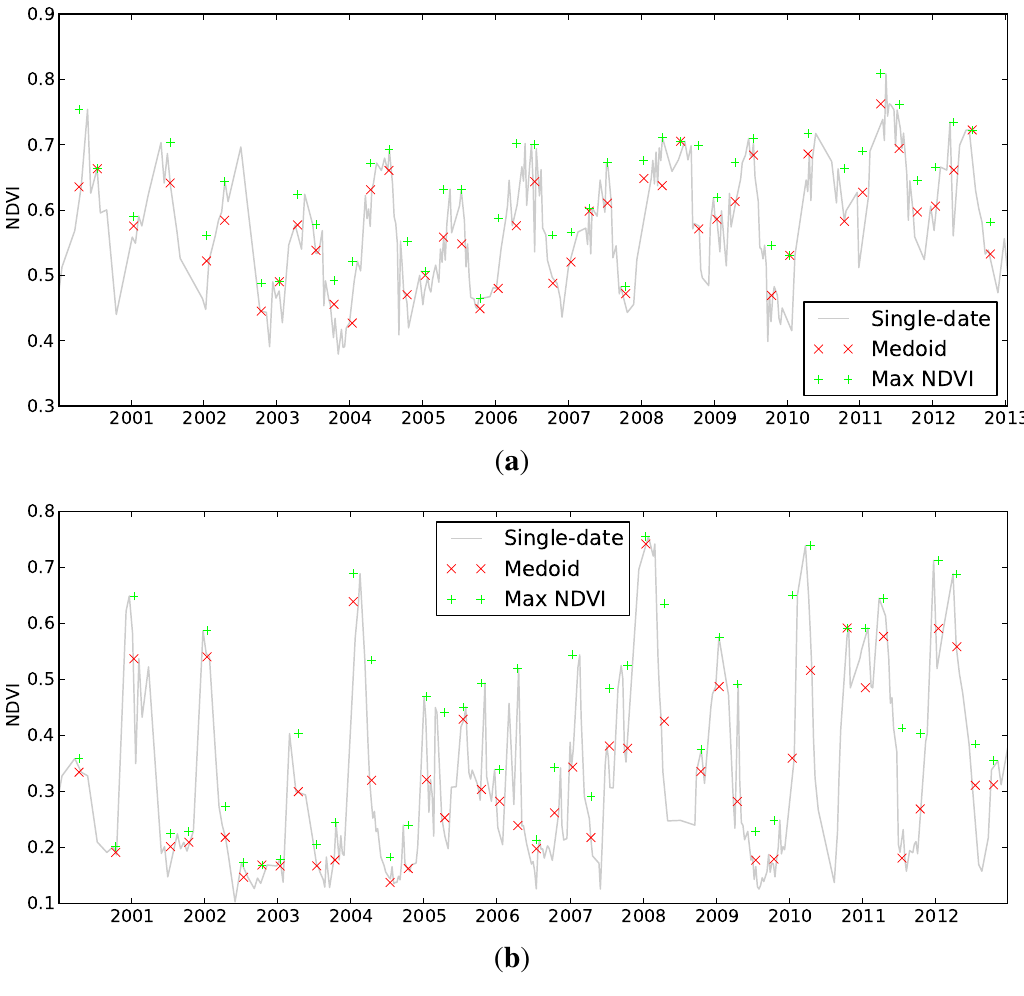
Figure 6. Time series of NDVI, for the two example pixels: ( a ) forest; ( b ) grassland. Seasonal values are marked as points. Seasonal NDVI is calculated directly from the seasonal